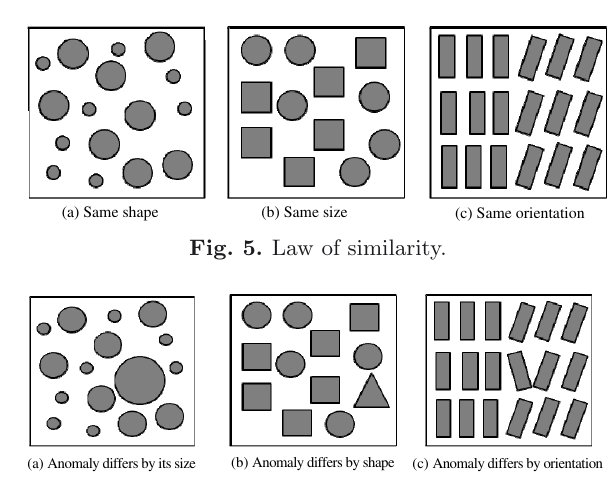
Fig. 4. Impact of an anomaly on the perceived quality [6].